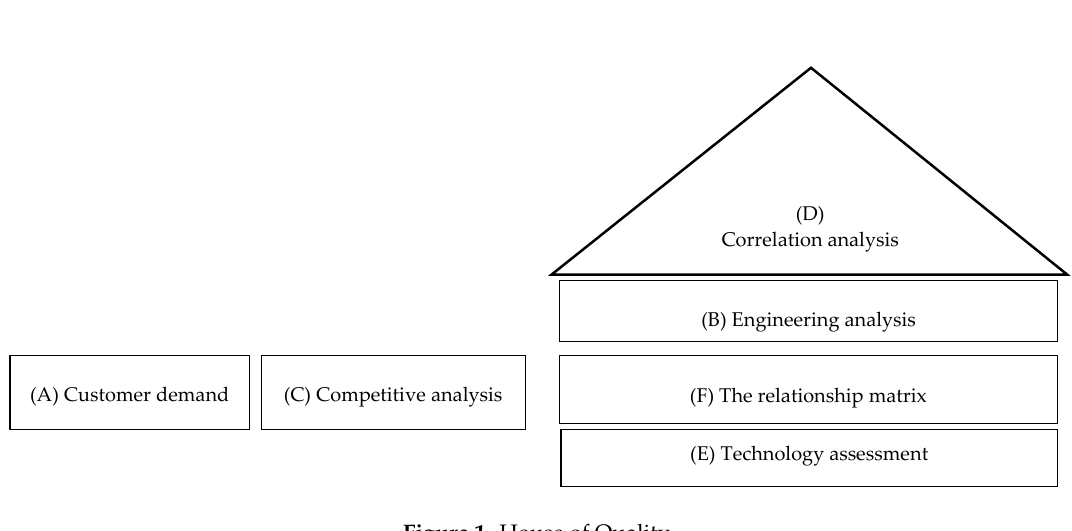
Figure 1. House of Quality.